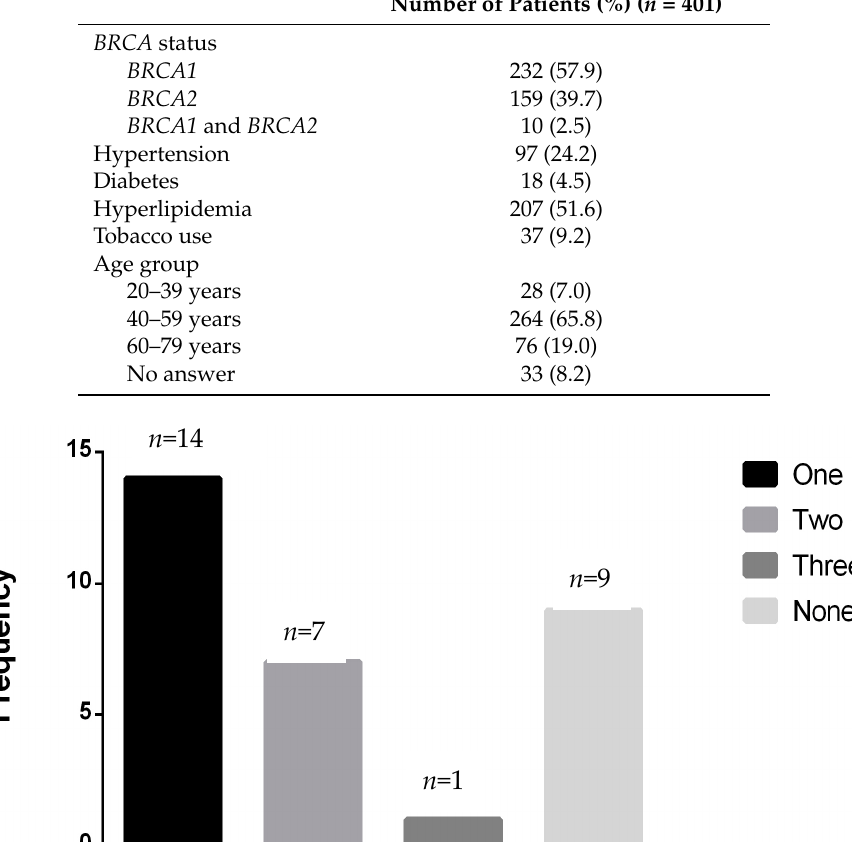
Figure 1. Number of confounding risk factors seen in the 31 BRCA patients with heart failure.